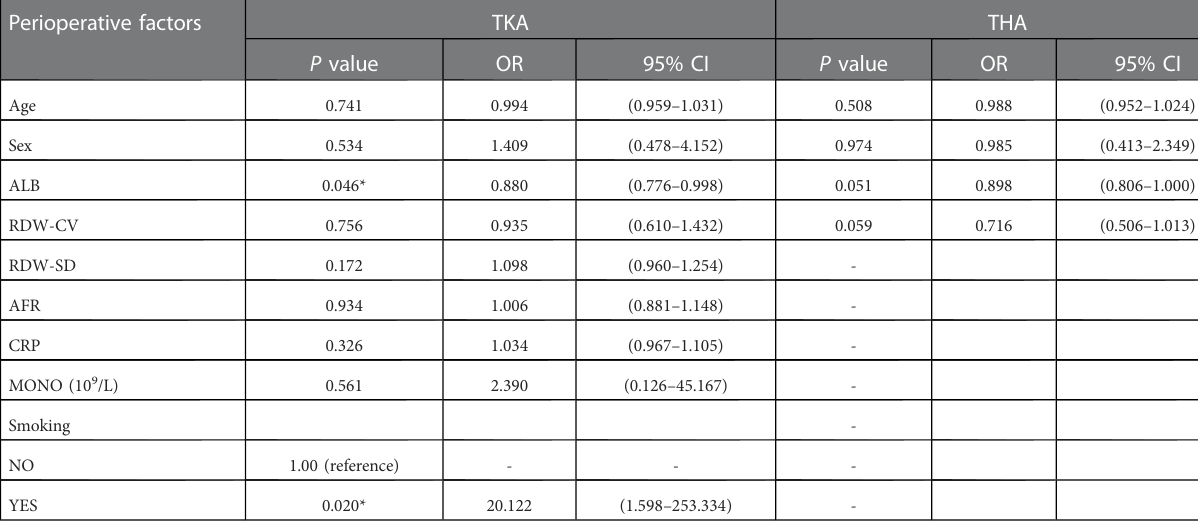
TABLE 4 Multivariable analysis of independent risk factors for acute postoperative infection after TKA and THA. Perioperative